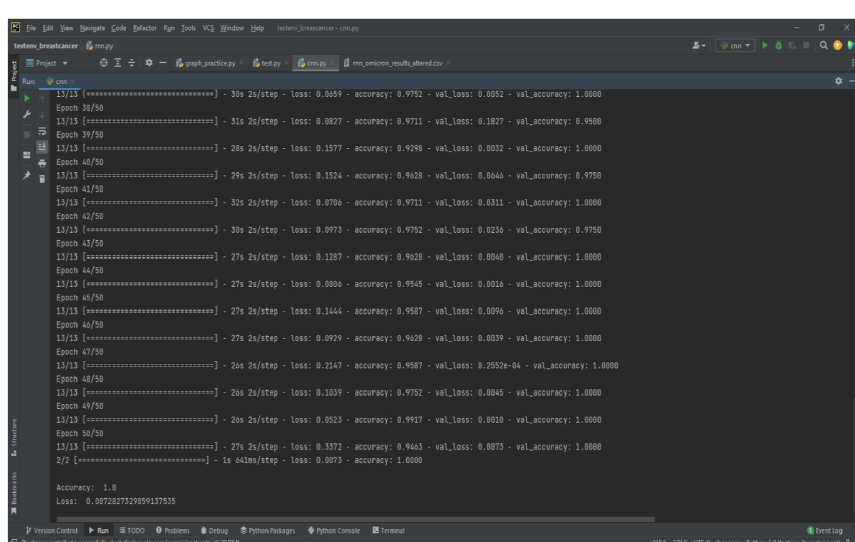
Figure 9: Final results of COVID-19 by using the ECNN